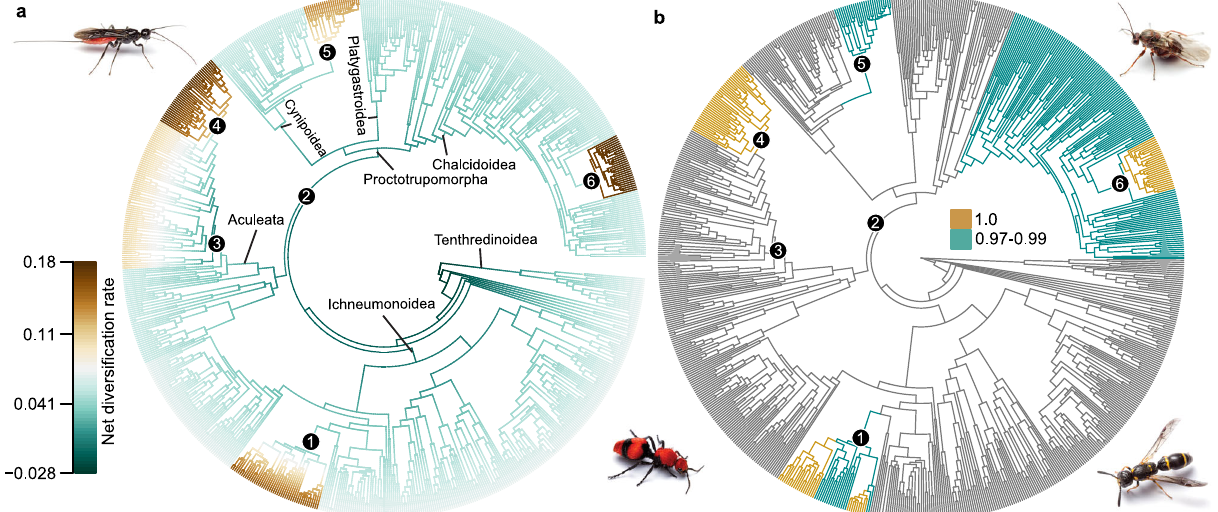
Fig. 3 | Diversi fi cation history of Hymenoptera. We assessed potential shifts in diversi fi cationratesover time inHymenopterausinga sampling fraction approach and clade-speci fi c sampling probabilities in BAMM v2.5 45,46 and the associated R packageBAMMtoolsv2.1.7 115 .AllanalysesshownarebasedontopologyC-1. a Plotof best shift con fi guration with maximum a posteriori probability (MAP), indicating rate shifts on respective branches. Rates are shown as net diversi fi cation rates. Sincethis rate shift con fi guration onlyhasa 0.019probabilityamong 9910 distinct shift con fi gurations in the 95% credibility set, we summarized the cumulative probabilities for each branch that a shift occurred somewhere between the focal branch and the root of the tree. b Cumulative shift probability tree, indicating in